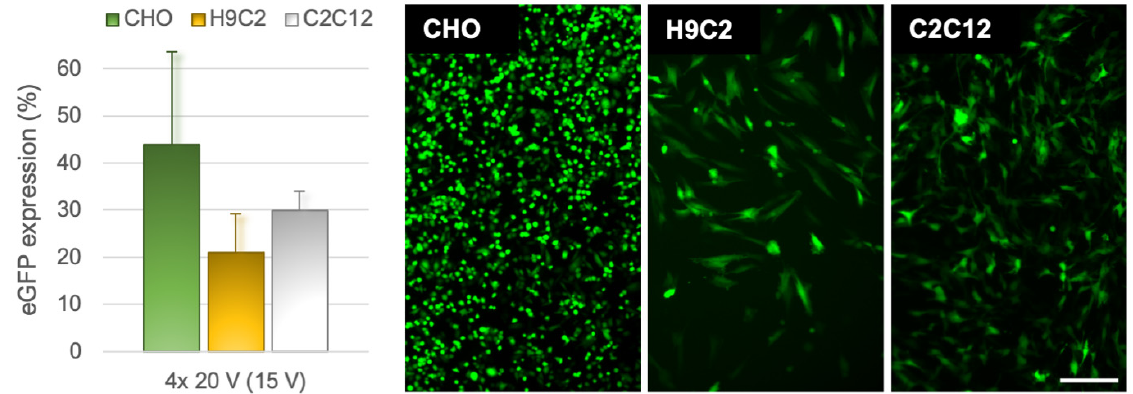
Figure 6. Transfection efficiency and cell survival in H9C2 and C2C12 cells. Experiments were performed in the same way as for CHO cells, but only using membranes with 0.4 µm substrate pores. ( a ) Percentage of cells expressing eGFP. ( b ) Percentage of viable cells. Graphs show mean ± s.d. from 3–4 experiments.